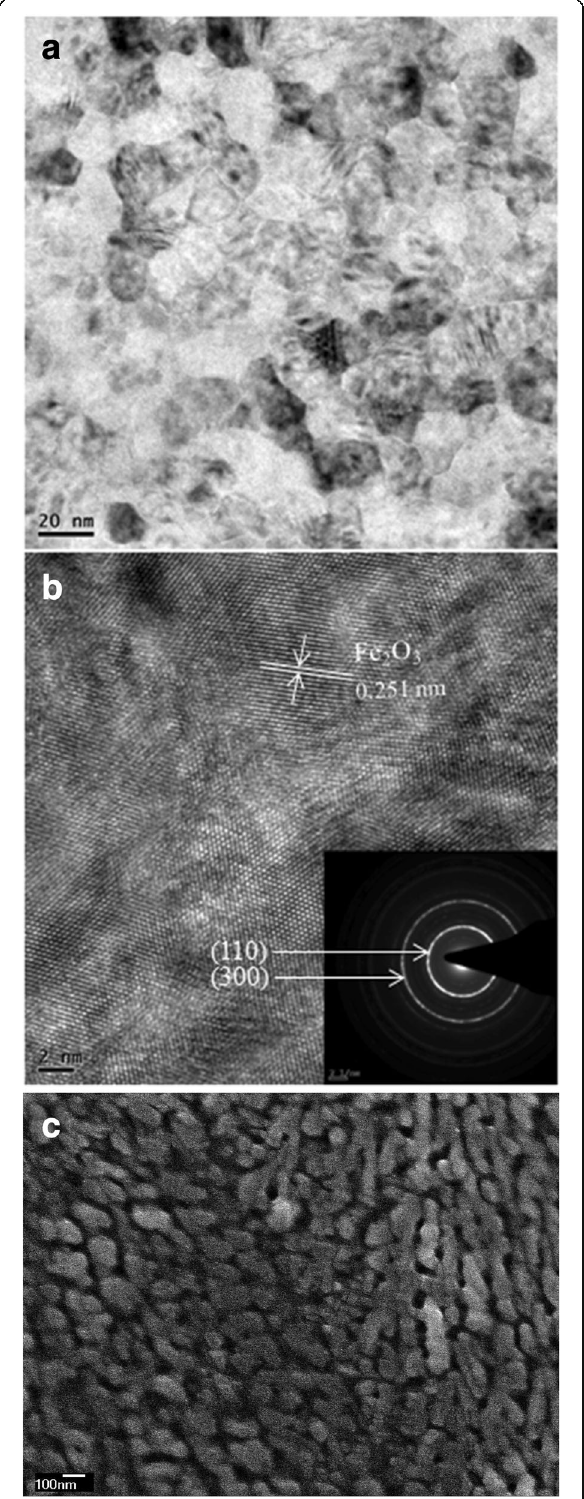
Fig. 2 a TEM image. b HRTEM image with inset showing SAED patterns. c SEM image of the Fe 2 O 3 film prepared at room